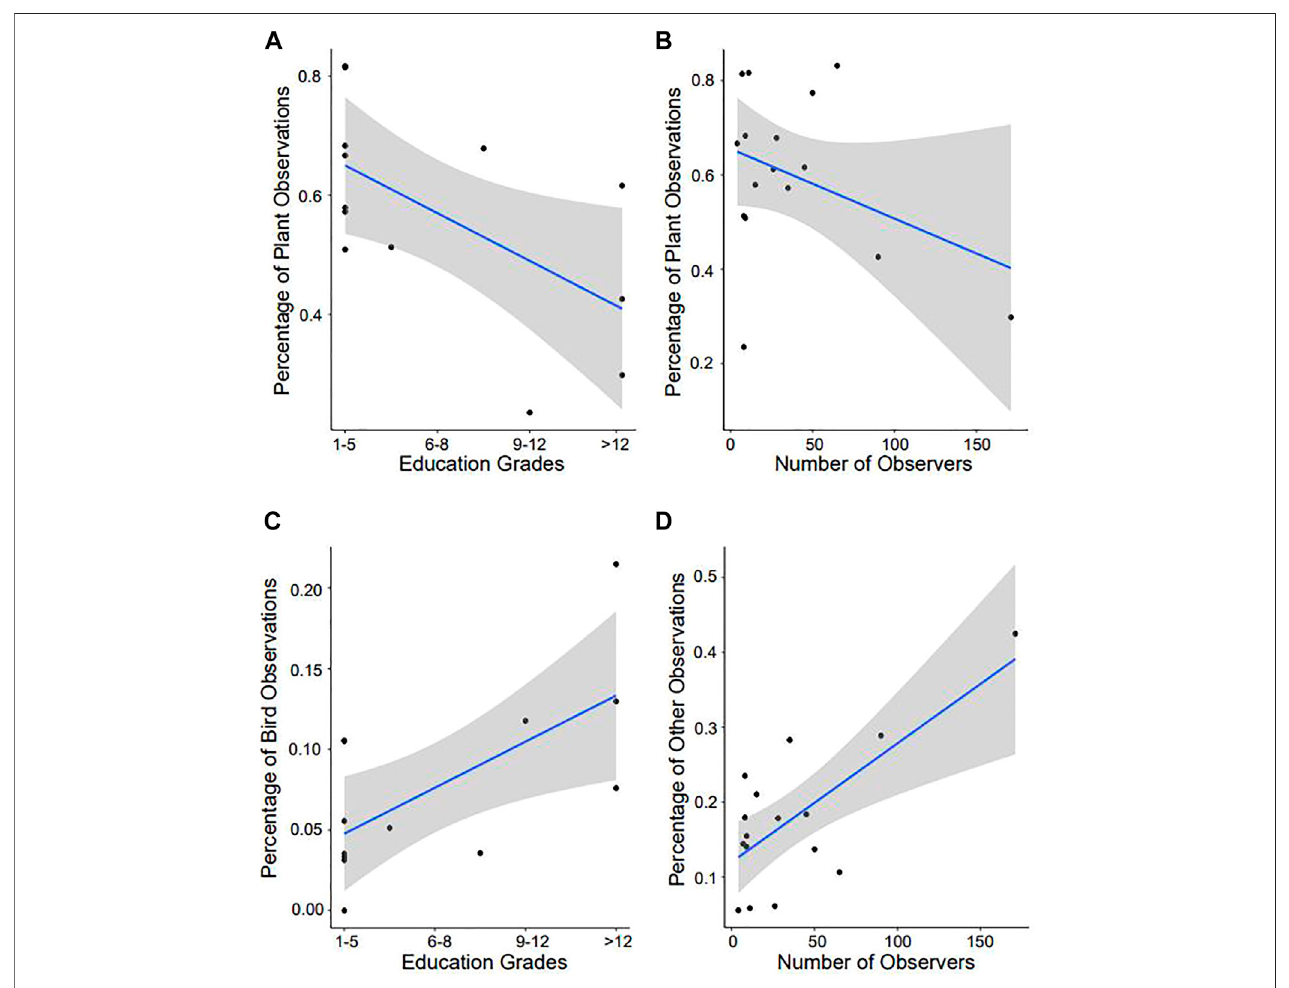
FIGURE5| Observer characteristics shaping type oftaxa datacollected. Figures representingobserver characteristics thatsigni fi cantly in fl uenced thepercentage of plants, birds, or other taxa are shown. The percentage ofplant observationswas signi fi cantly in fl uenced by (A) increasing education level and (B) increasing numbers of observers. (C) Percentage of bird observations increased with education level, and (D) percentage of other observations increased with increasing numbers of observers. Regression lines show linear regressions with 95% con fi dence intervals.